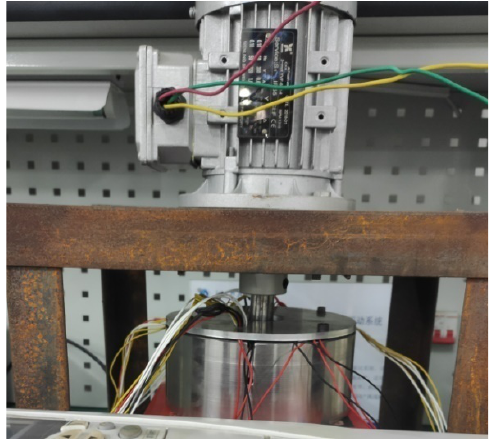
Figure 5. Diagram of 3 ‐ DOF motor with permanent magnet rotor deflection.